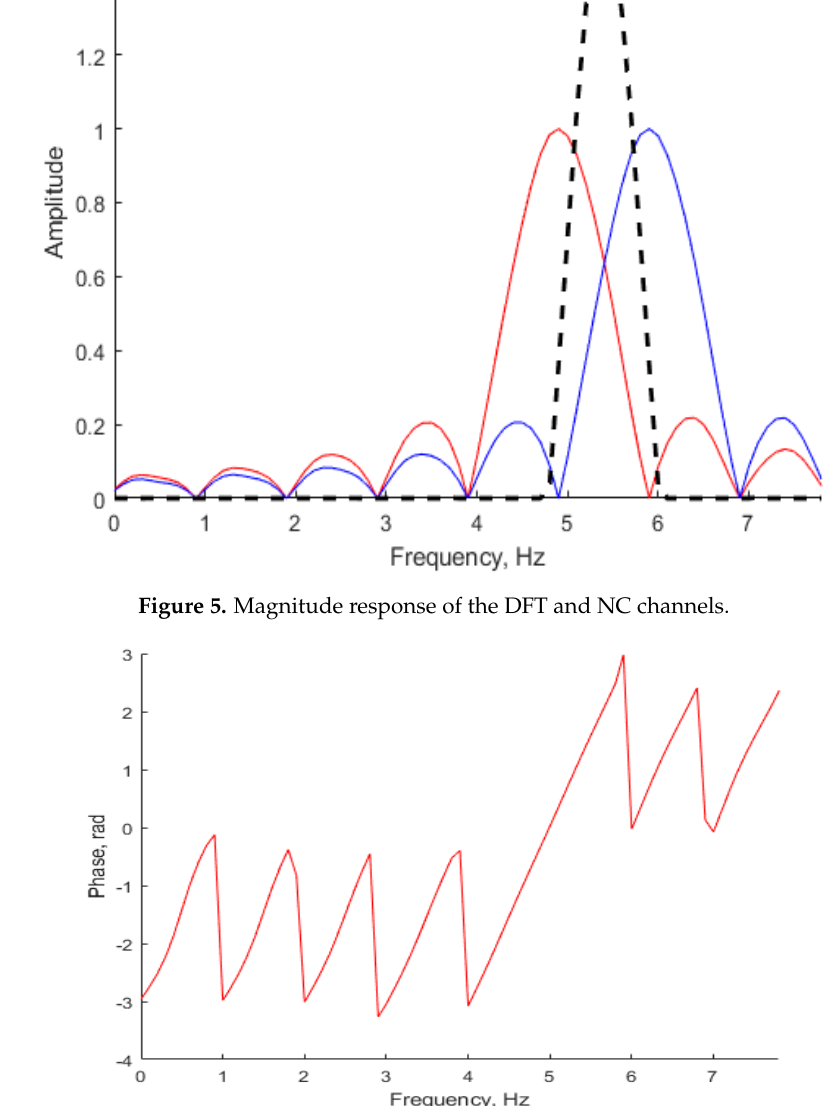
Figure 6. Phase-frequency characteristic of the DFT.